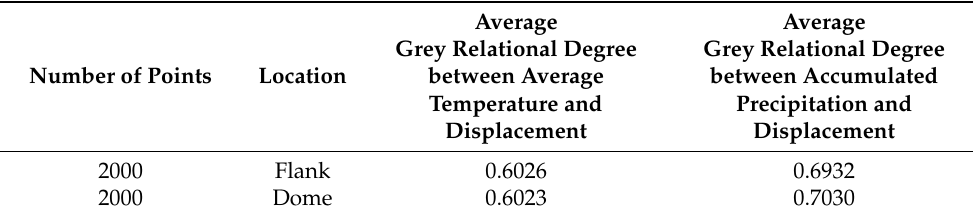
Table 6. The average grey relational degree between the absolute value of the time series displace- ment, average temperature, and accumulated precipitation during the Sentinel-1A image acquisition time interval.